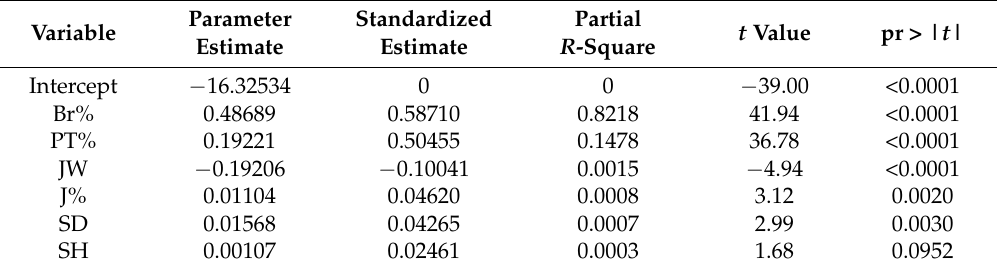
Table 4. Stepwise regression model for RS% as dependent variable and the remaining characters as independent